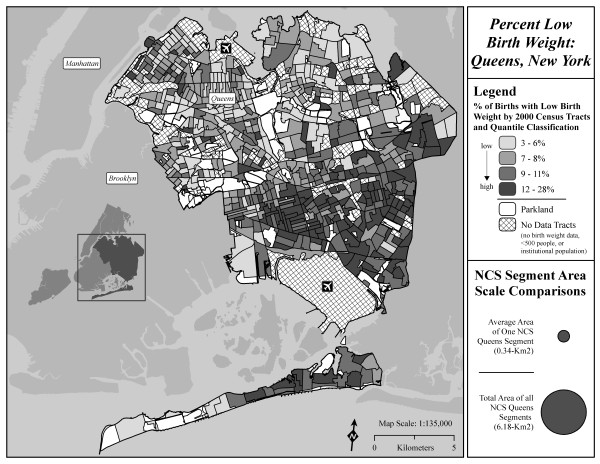
Distribution of percent low birth weight (<2500 g) in Queens Census tracts. In comparison to the area of Queens (281.59 km2) shown on the map, the circles in the legend of the maps represent the total area of the 18 segments (middle circle - 6.18 km2) and the average area of a Queens NCS segment (smallest circle – 0.34 km2).